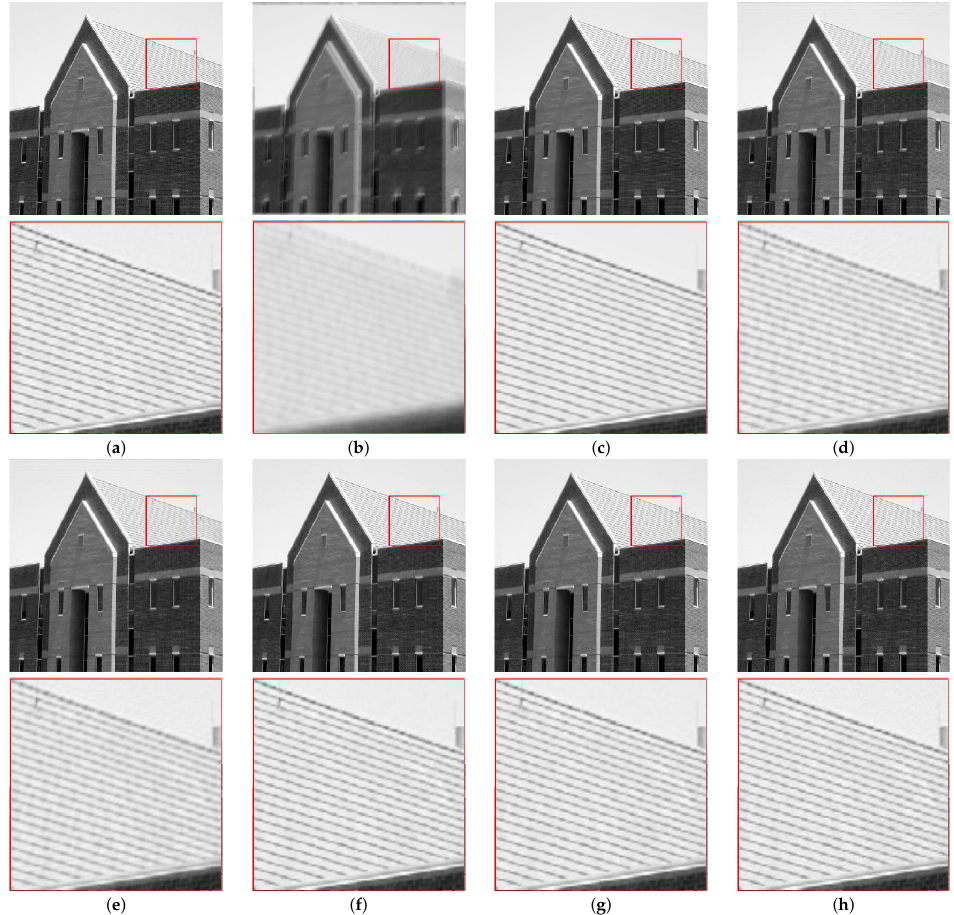
Figure 4. The building image restored by all algorithms. ( a ) Building, ( b ) degraded, ( c ) IDBP, ( d ) D-ADMM(a), ( e ) D-ADMM(i), ( f ) APE-TV, ( g ) APE-TGV, and ( h ) D-TGV.